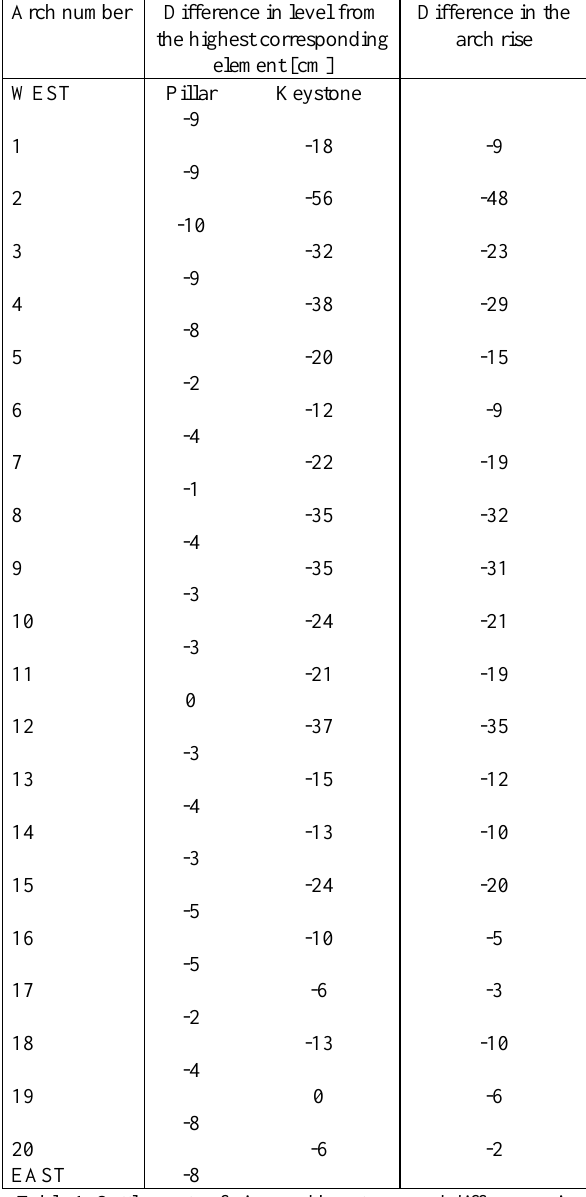
Table 1. Settlements of piers and keystones and differences in the arches drops, measured on the geometrical